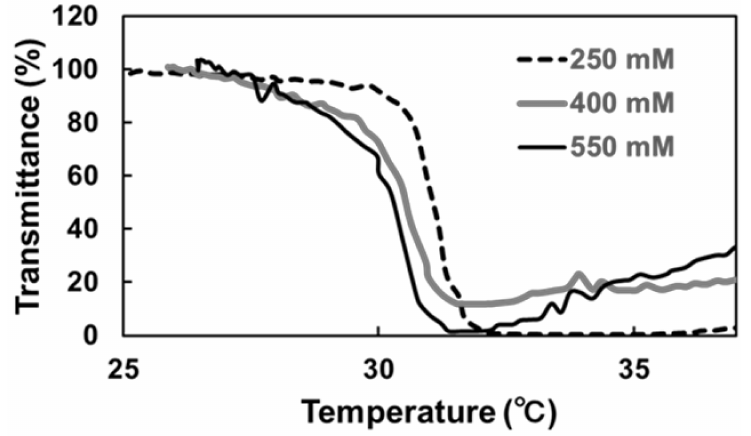
Figure 5. Transmittance of the IgG–PNIPAAm solutions as a function of temperature (thermal- response; solvent: PBS (pH: 7.4), IgG concentration: 0.0625 mg/mL, heating rate: 0.2 ◦ C/min, wavelength: 450 nm).